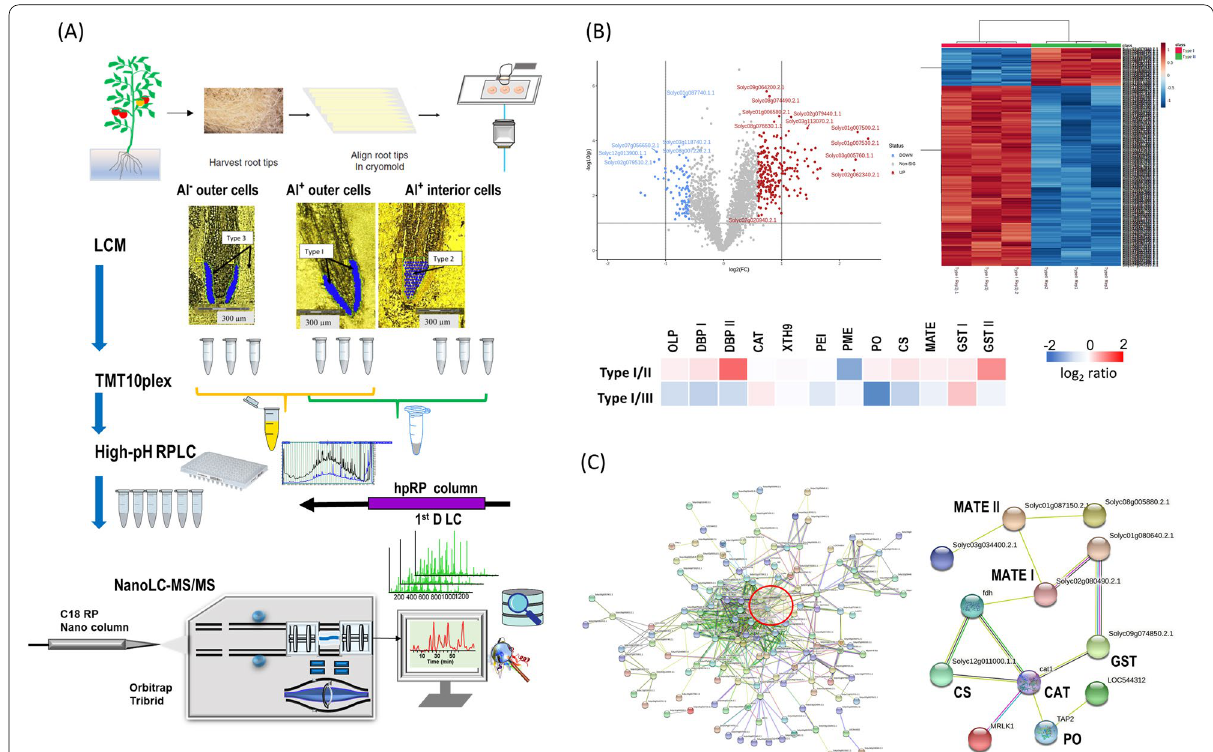
Fig. 3 Identification of Al-induced proteomes in outer layer cells and interior of tomato root-tips. A TMT comparative proteomics analysis of differentially abundance proteins (DAPs) on tomato root-tips samples using laser capture microdissection (LCM); B Heatmap analysis based on ANOVA and Volcano plot for the DAPs between type I and type II tissues; C Protein network analysis by STRING (https:// string- db. org/) for the DAPs found between type I and type II